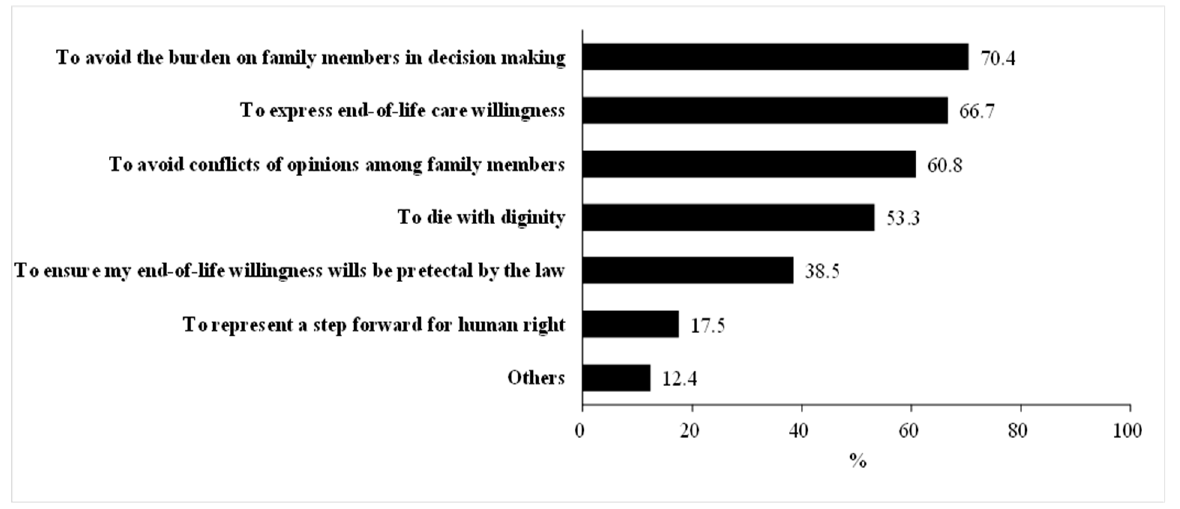
Figure 1. T he reasons for willingness to engage in ACP (multiple options could be selected). Figure 1. The reasons for willingness to engage in ACP (multiple options could be